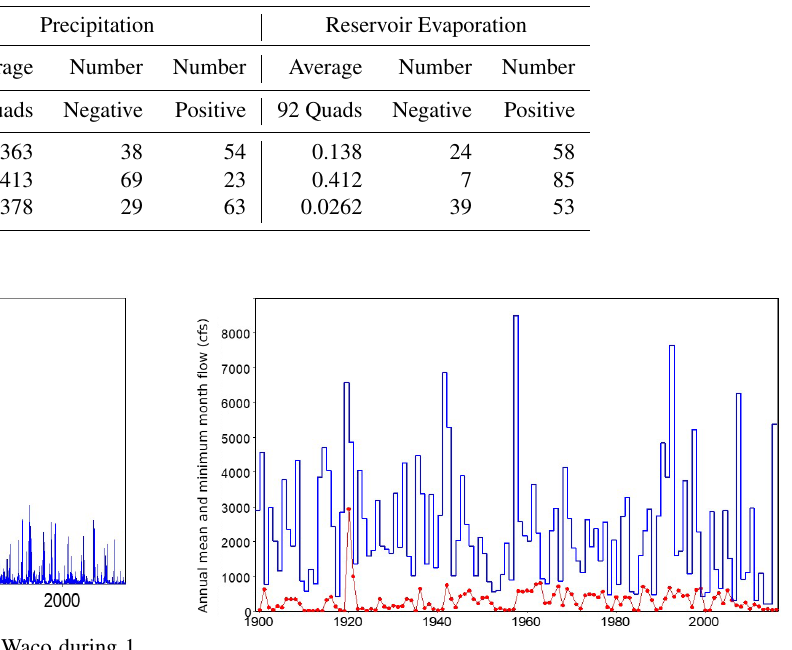
Table 2. Statistics for mean statewide precipitation and evaporation.